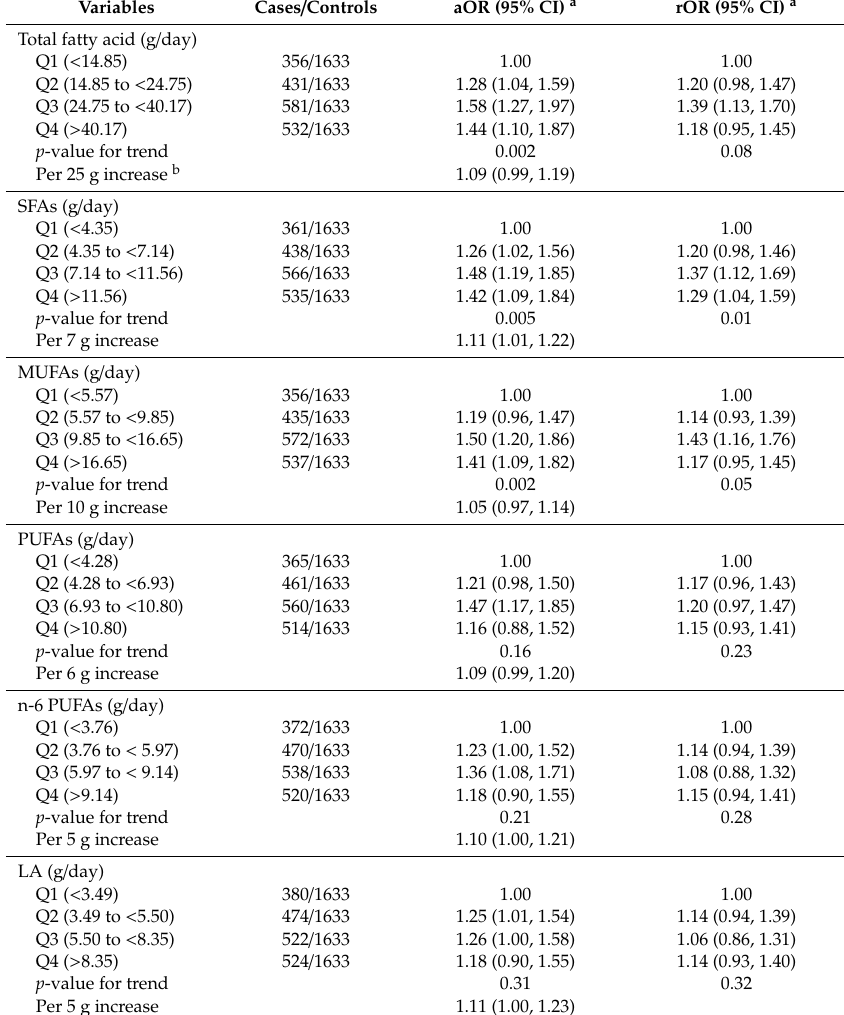
Table 3. The associations between dietary fatty acids and total cholesterol intakes and stomach cancer among individuals with a normal range of total energy intake (cases = 1900, controls = 6532). Variables Cases / Controls aOR (95% CI) a rOR (95% CI) a Total fatty acid (g / day) Q1 ( < 14.85) 356 / 1633 1.00